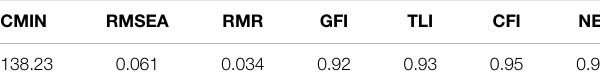
TABLE 5 | Latin American: Goodness of fi t